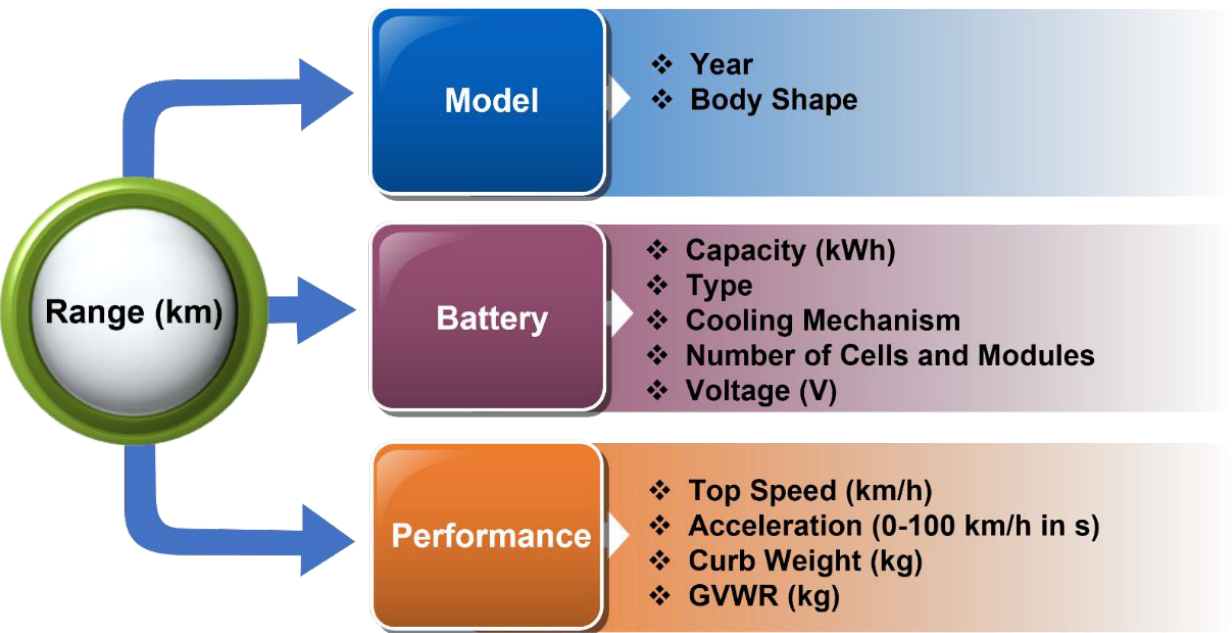
Figure 2. EV model, battery, and performance features considered from the dataset.